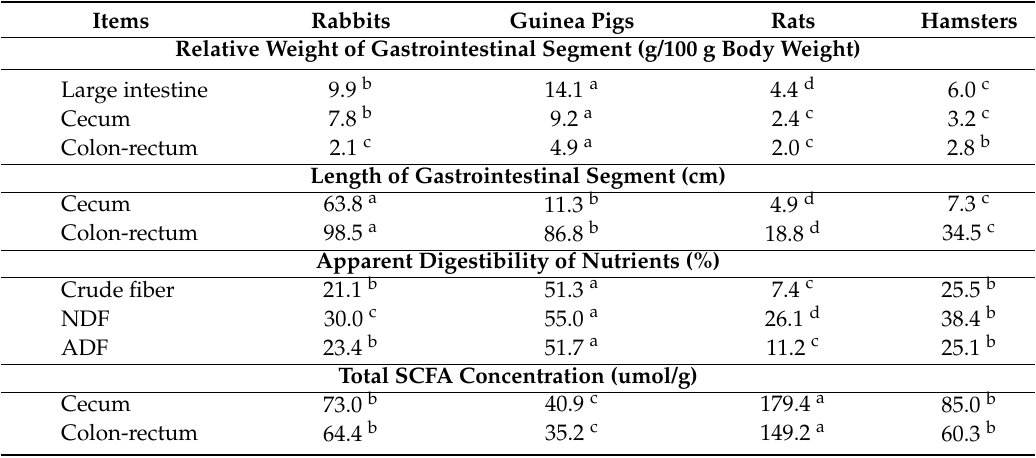
Table 1. Comparison of weight and length of hindgut, fiber digestibility and total SCFA concentration in rodents and